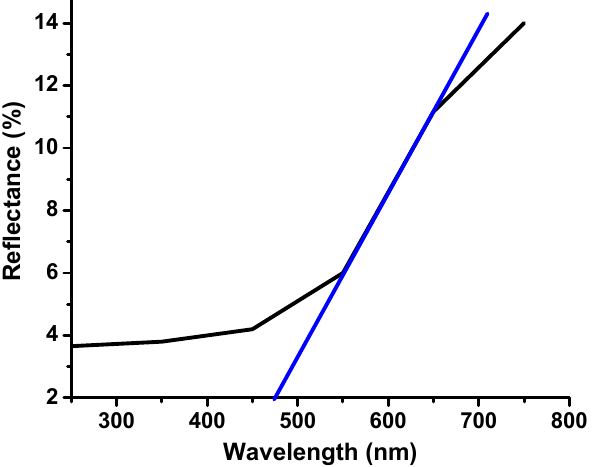
Figure 5. UV-Vis-diffuse reflectance spectra of the Cu-ZnO/TiO 2 (CZT-2) nanocomposite photocata- lyst.